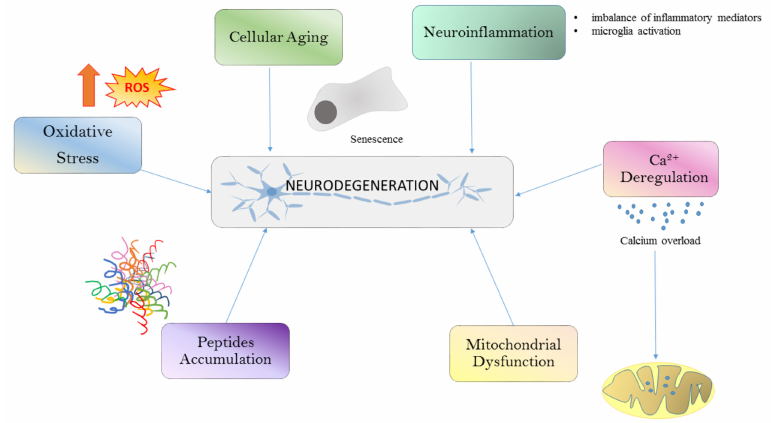
Figure 1. Common pathways that lead to neurodegeneration. Neuronal damage in neurodegenera- tive diseases is induced by ROS generation, cellular aging, neuroinflammation, Ca 2+ dysregulation, mitochondrial dysfunction and peptide accumulation. ROS, reactive oxygen species.